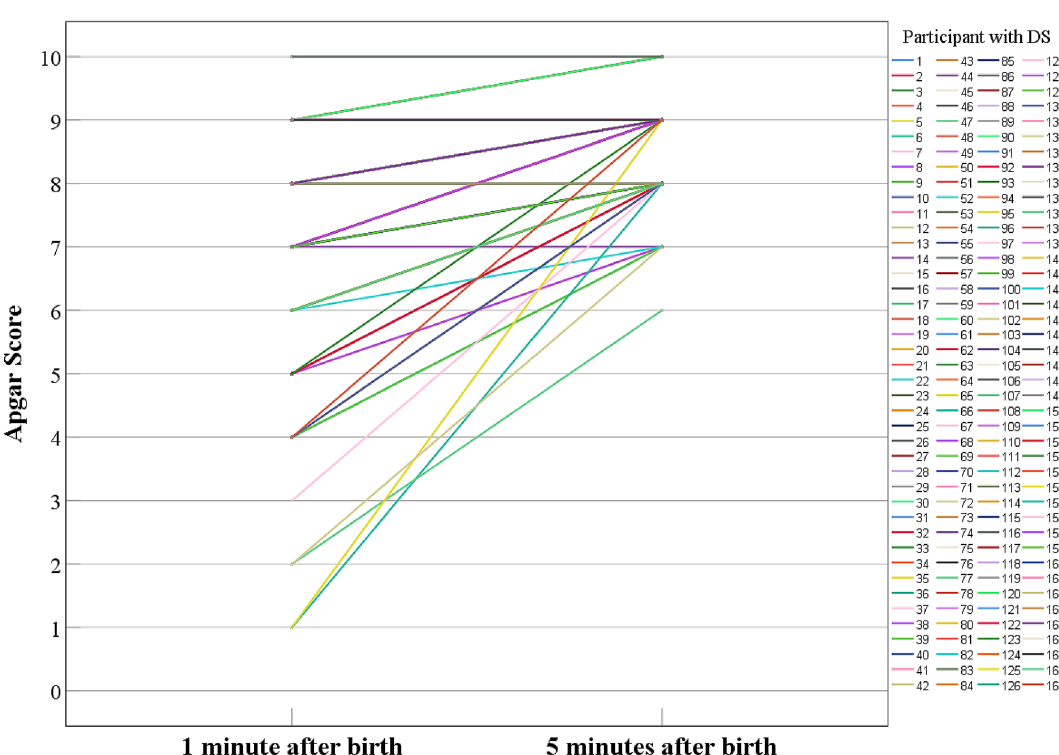
Figure 1. Spaghetti plot representing Apgar score trajectory from one to five minutes after birth in each participant with DS. Each line represents a participant with DS. Several trajectories overlap between